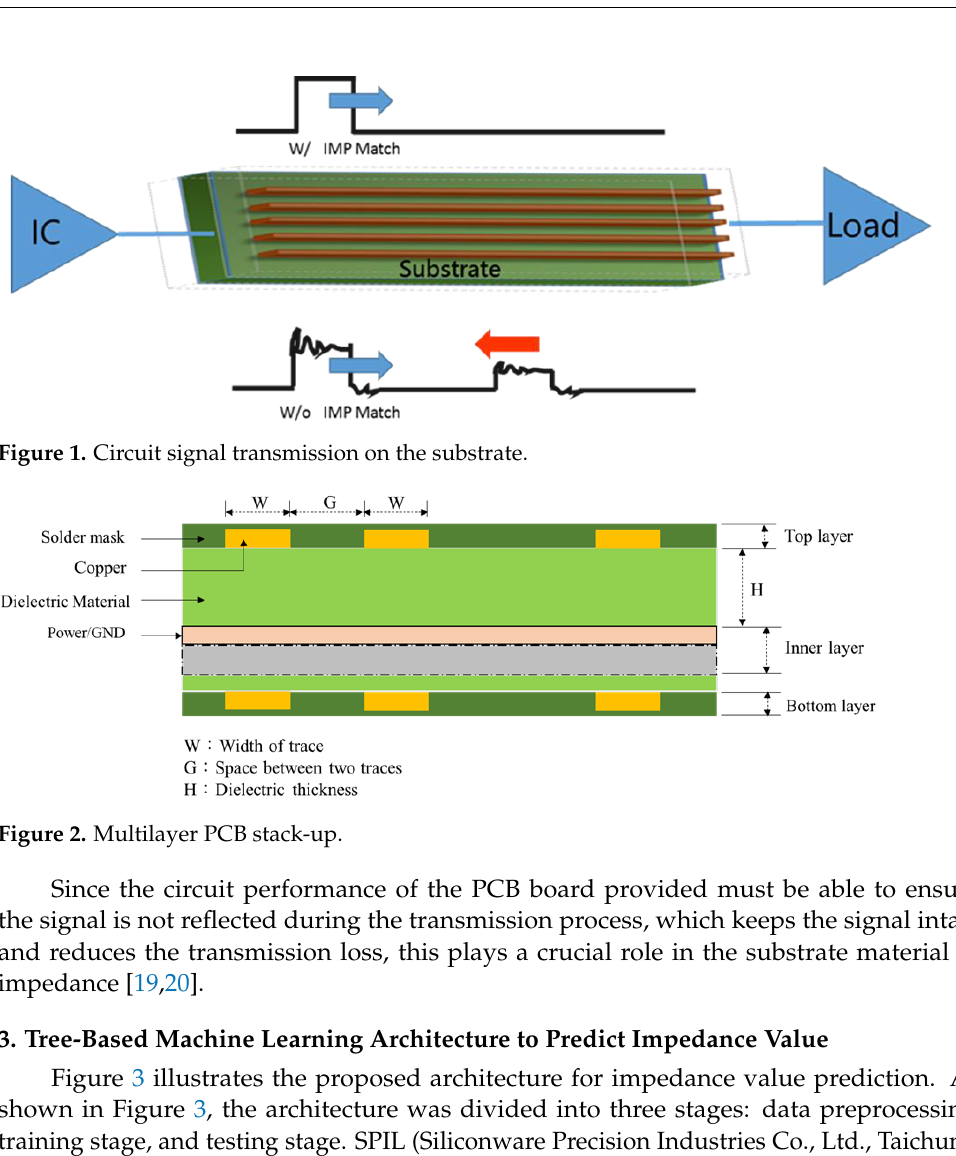
Figure 2. Multilayer PCB stack-up.